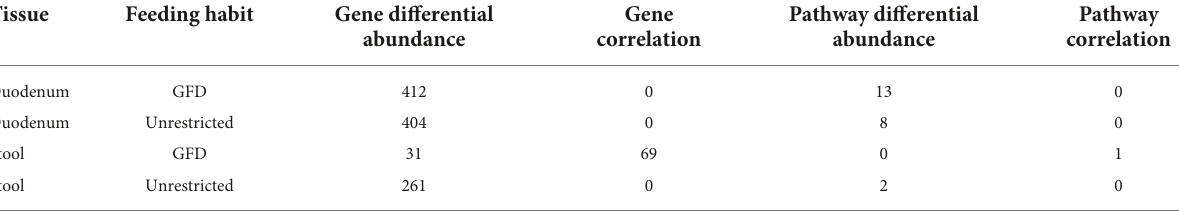
TABLE 3 Statistics of significant results obtained on Picrust2 predictions